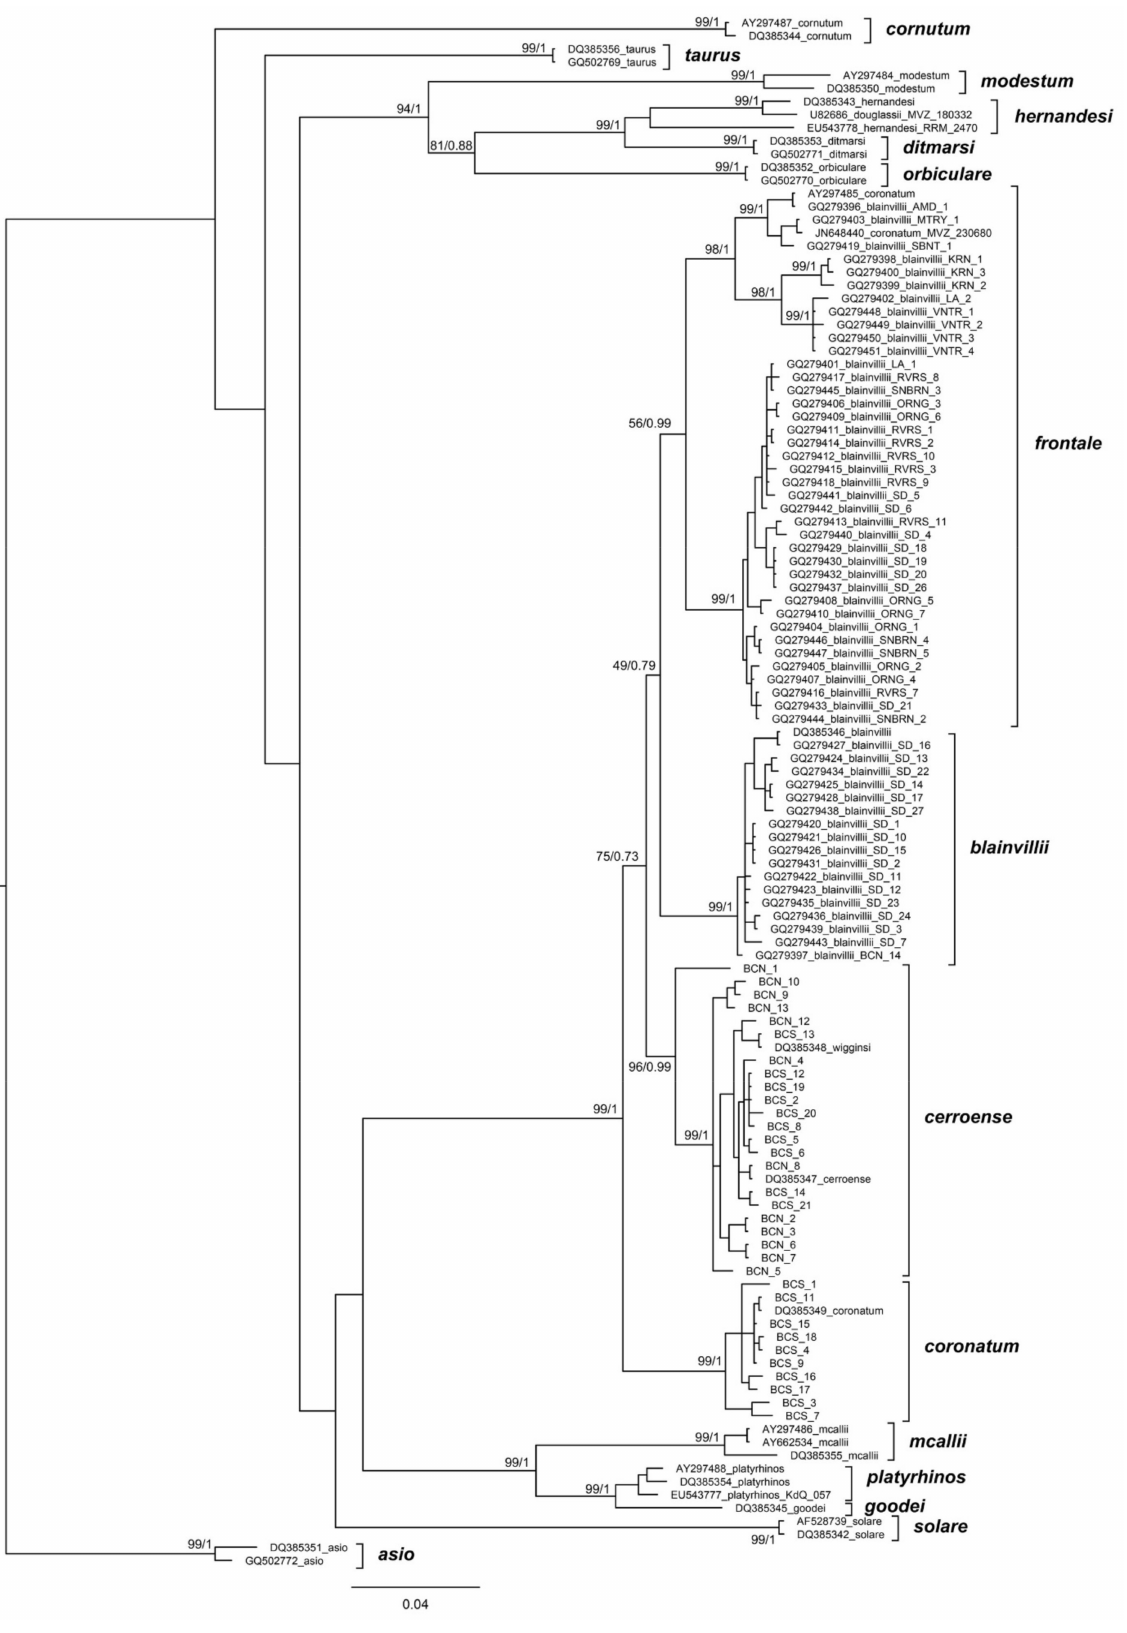
Figure 3. Phylogenetic tree of taxa in the genus Phrynosoma from a Bayesian analysis of the ND2 dataset. A scale bar of genetic distance is indicated. Numbers at nodes are bootstrap values (left) and Bayesian posterior probabilities (right). Only nodes with bootstrap values higher than 75 are shown. Bold names and brackets indicate recognized